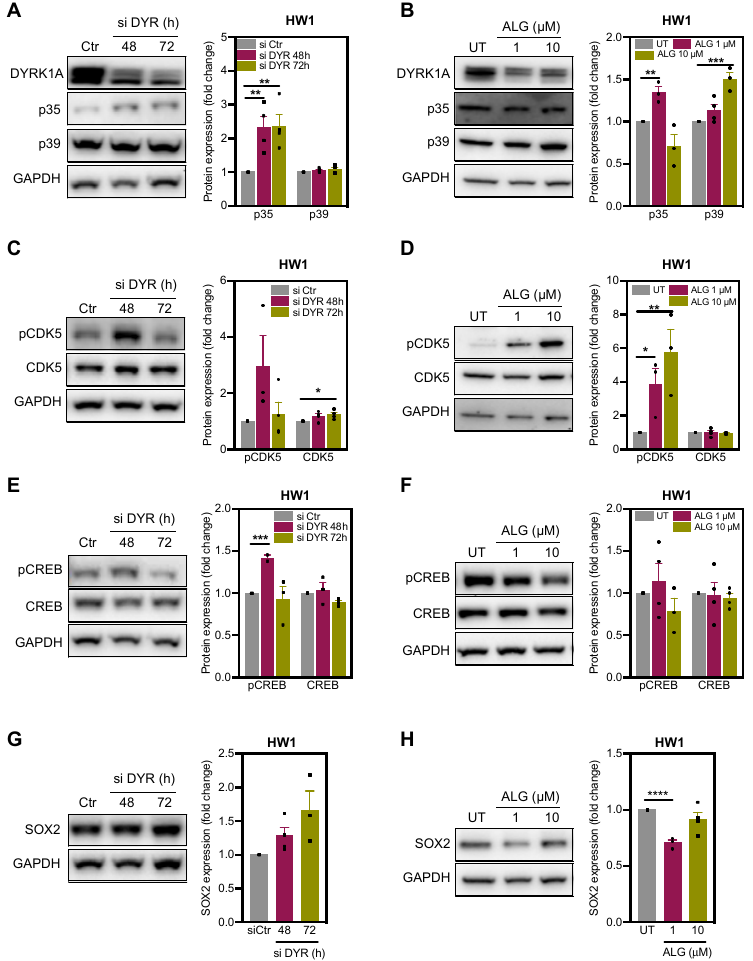
Figure 4. DYRK1A inhibition activates CDK5 pathway in HW1 glioblastoma stem cells. ( A , B ) Im- munoblot images and quantification of DYRK1A, p35 and p39 in HW1 cells transfected with scramble (si Ctr) and DYRK1A (si DYR) targeting siRNAs or treated with DYRK1A inhibitor ALGERNON (ALG, 72 h)( n = 3–4). ( C , D ) Immunoblot images and quantification of phosphorylated (p-CDK5) and total CDK5 in HW1 transfected with si Ctr and si DYR, or treated with ALG (72 h)( n = 3–4). ( E , F ) Immunoblot images and quantification of phosphorylated (p-CREB) and total CREB in HW1 cells transfected with si Ctr and si DYR, or treated with ALG (72 h)( n = 2–4). ( G , H ) Immunoblot images and quantification of SOX2 in HW1 cells transfected with si Ctr and si DYR, or treated with ALG (72 h). ( n = 3–4). All bar graphs represent mean ± SEM (two-tailed, unpaired t-test, * p < 0.05, ** p < 0.01, *** p < 0.001, **** p < 0.0001).